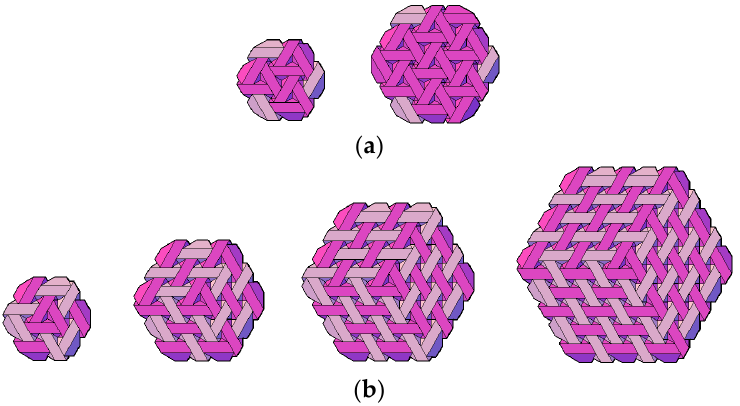
Figure 8. Hexagonal slabs composed of rhombic components: ( a ) joined three into hexagonal sets; ( b ) shaped analogically to a square vault.